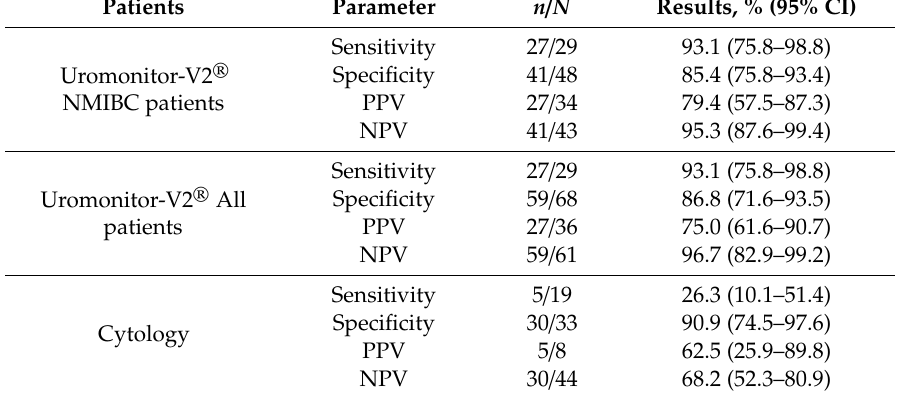
Table 3. Comparing Uromonitor-V2 ® test characteristics with urine cytology.